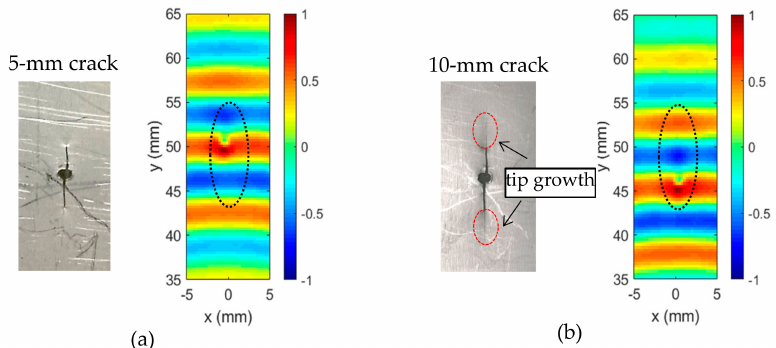
Figure 7. Wavefield comparison at 35 µ s showing wave interactions with cracks of di ff erent lengths: ( a ) 5-mm fatigue crack and ( b ) 10-mm fatigue